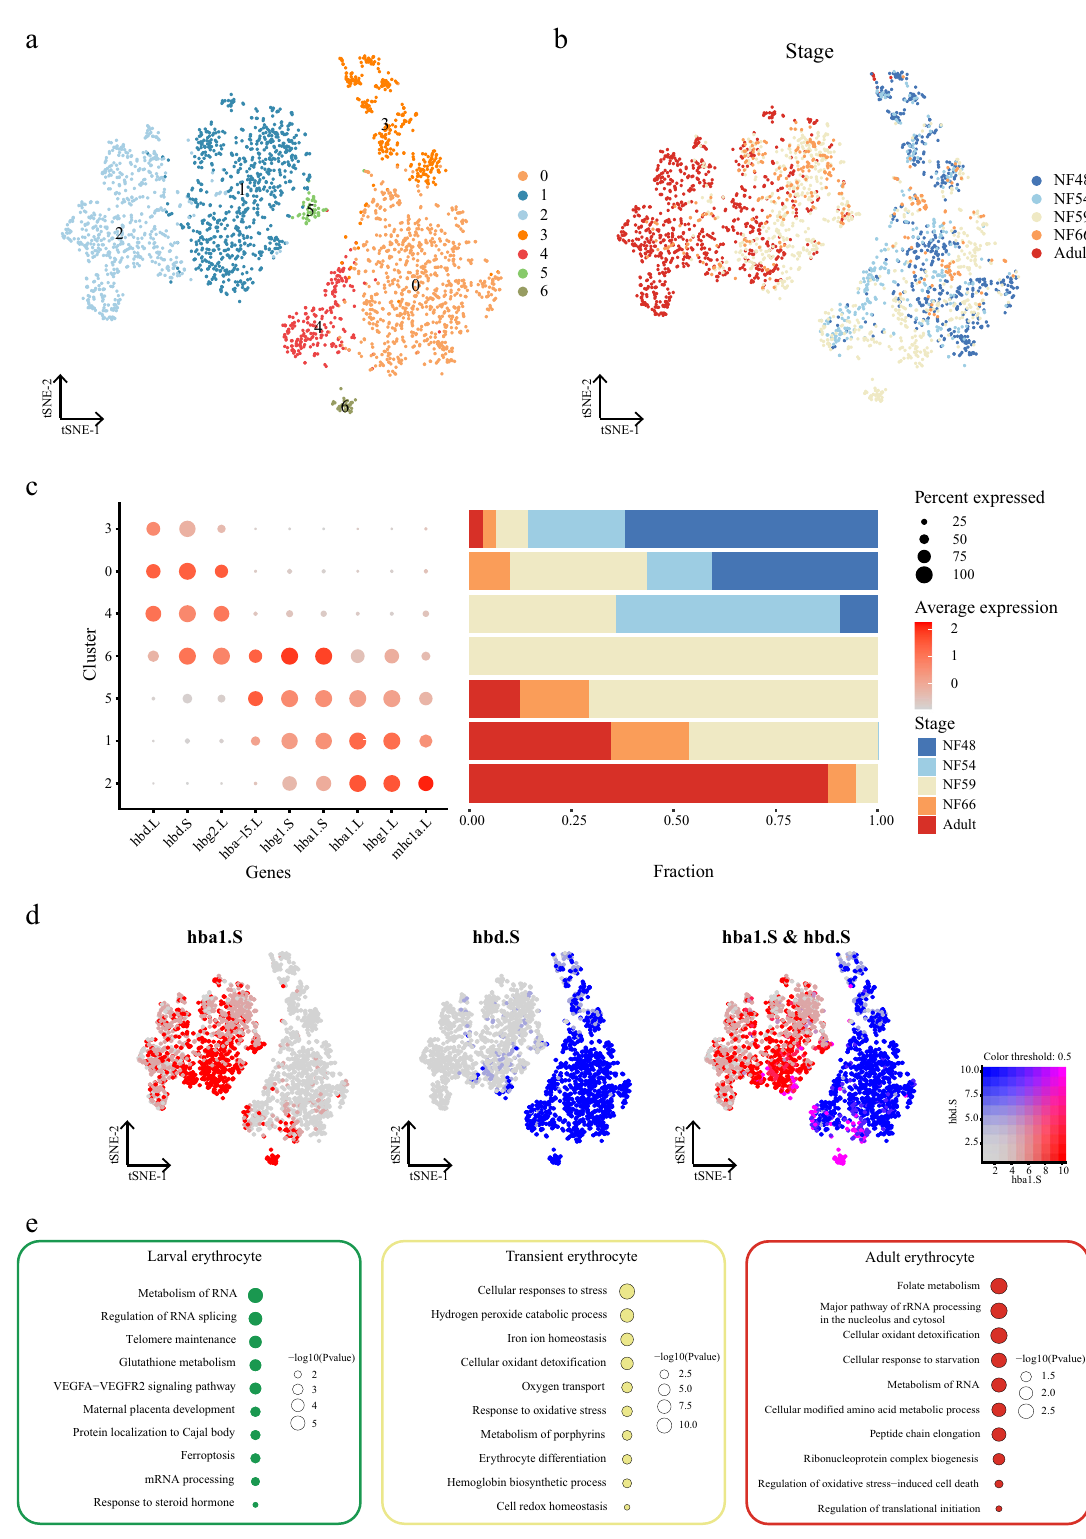
metabolic processes are common biological processes in Xenopus metamorphosis for major cell